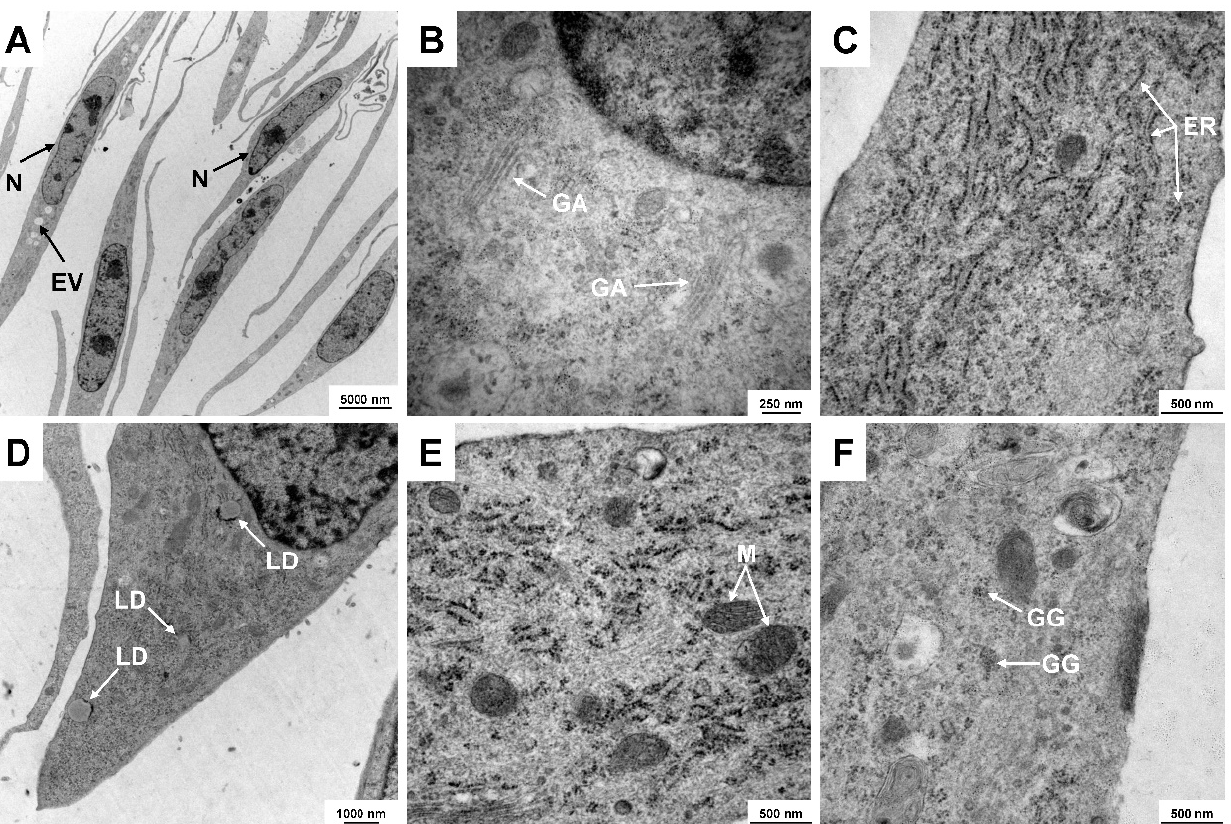
Figure 4. Representative electron microscopic analysis of CFSC-2G. Typical ultrastructural features of this cell line are ( A ) large nuclei (N) and endolysomal vesicles (EV), ( B ) prominent Golgi apparatus (GA), ( C ) remarkable rough endoplasmic reticulum (ER), ( D ) intracellular lipid droplets (LD), ( E ) large mitochondria (M), and ( F ) glycogen granules (GG). Original magnifications: ( A ) 2156×, ( B ) 35,970×, ( C ) 27,800×, ( D ) 7750×, and ( E , F ) 27,800×. The cell line CFSC was originally established from adult male Wistar rat cirrhotic liver and shown to express typical HSC markers including collagens (type I, III, and IV), Fibronectin, and laminin [7,8]. In agreement with this former characterization and the proposed ancestry from HSC, we could confirm the expression of typical HSC markers including Fibronectin, α -smooth muscle actin ( α -SMA), collagen type I, and Vimentin. Moreover, the cells were negative for SV40T that was used for immortalization of many other continuous HSC lines, such as LX-1, LX-2, HSC-T6, SV68-IS, A640-IS, IMS/MT (-), IMS/N, and Col-GFP HSC (Figure 5)